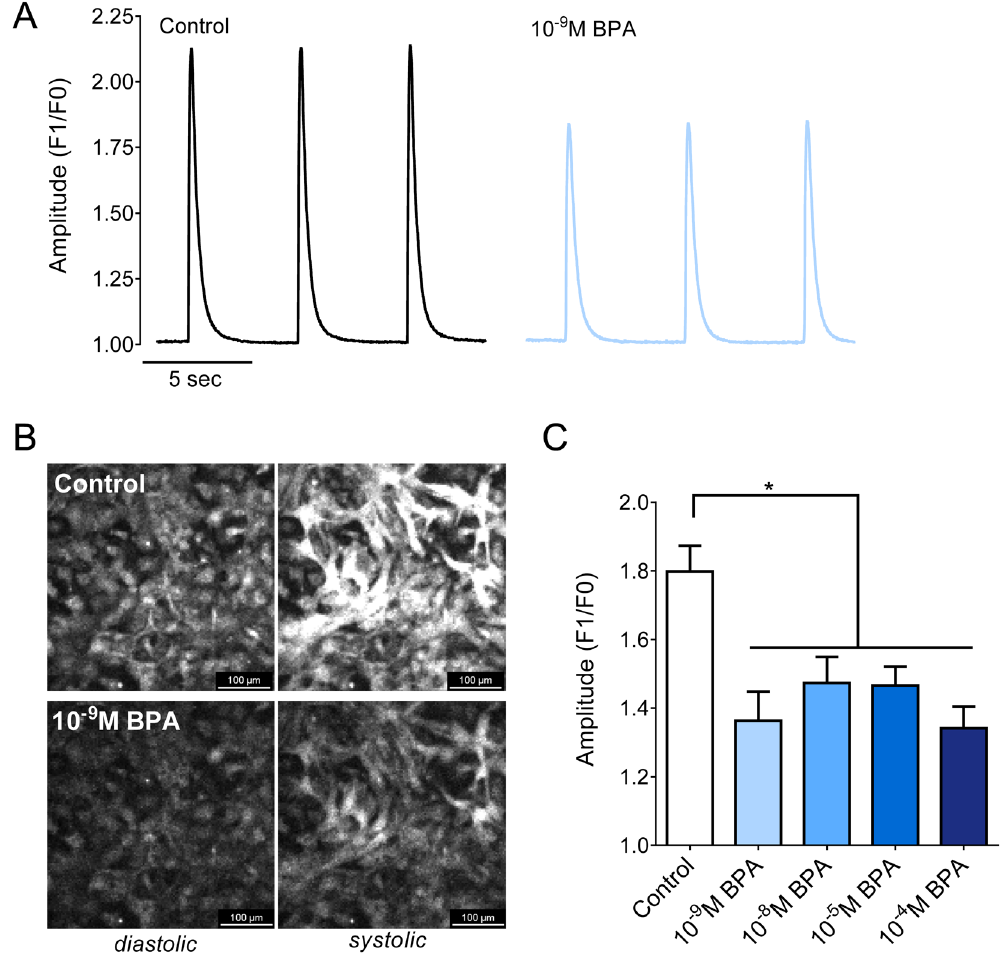
Figure 3. Acute BPA exposure reduces calcium transient amplitudes. ( A ) Representative CaT recorded from neonatal cardiomyocytes under control conditions, and following supplementation with 10 − 8 M BPA. Cardiac monolayers were paced at 0.2 Hz using field stimulation. ( B ) Representative images show the fluorescence intensity of Fluo-4AM corresponding to diastolic (baseline) and systolic intracellular calcium (peak). ( C ) Mean CaT amplitude measured by fluorescent calcium indicator dye (Fluo4-AM), F1 = peak fluorescence amplitude, F0 = baseline fluorescence, * p ≤ 0.05, n ≥